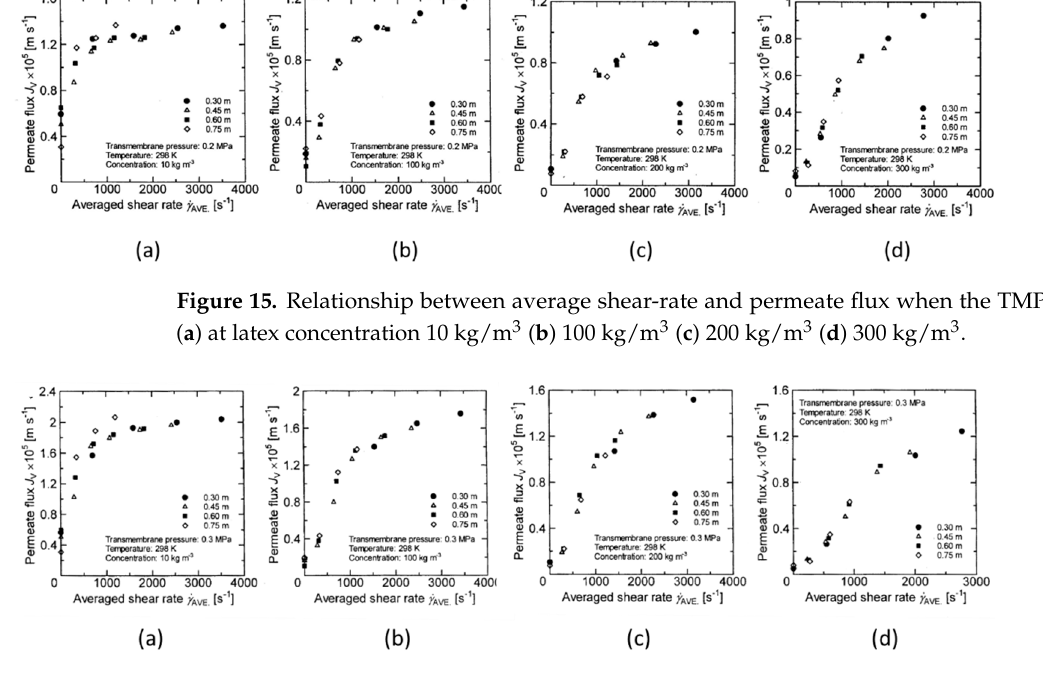
Figure 16. Relationship between average shear-rate and permeate flux when the TMP is 0.3 Mpa. ( a ) at latex concentration 10 kg/m 3 ( b ) 100 kg/m 3 ( c ) 200 kg/m 3 ( d ) 300 kg/m 3 .